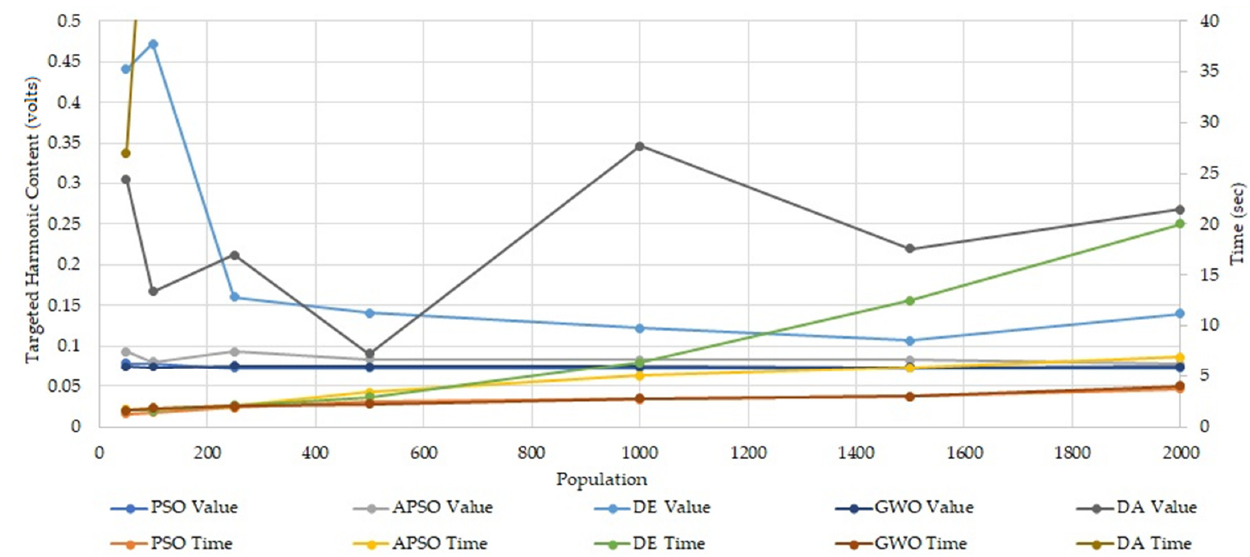
Figure 9. Summary of algorithms’ performance for an eleven-level inverter. Table 5. Percentage harmonics (w.r.t. fundamental) for eleven - level CHB inverter.